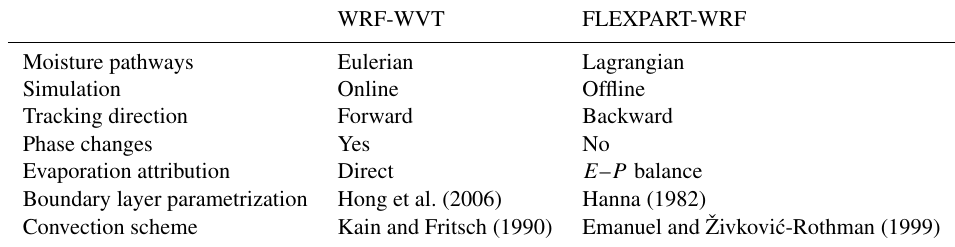
Table 1. Some differences between the WRF-WVT model and the FLEXPART-WRF